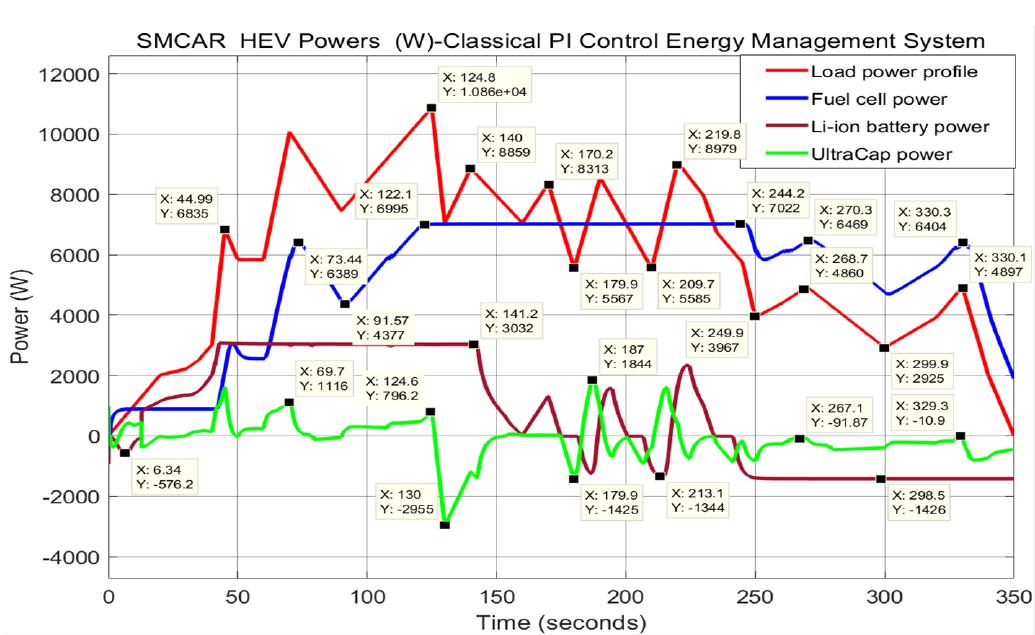
Figure A2. SMCAR HEV Powers—classical PI control EMS.